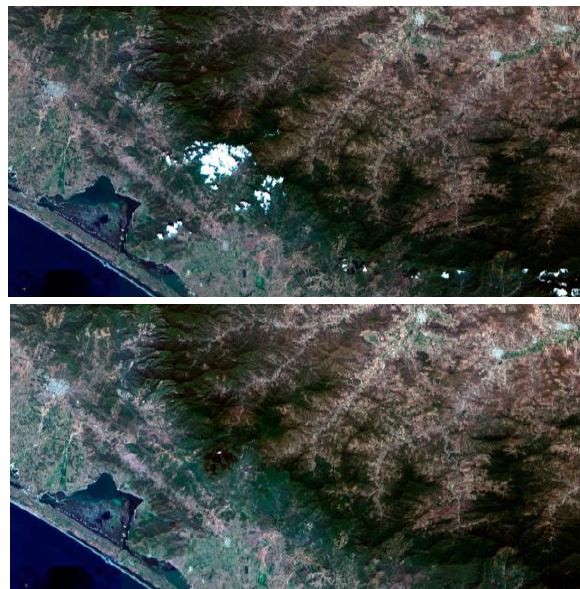
Figure 3. Mosaic prototype (above) vs. cloud stamped version (below); detail from the state of